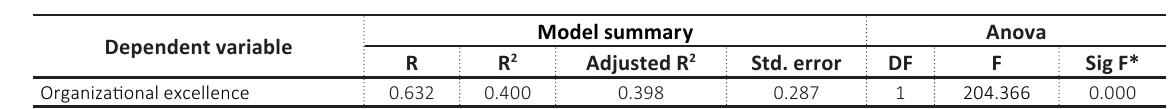
Table 7. Simple linear regression for H03